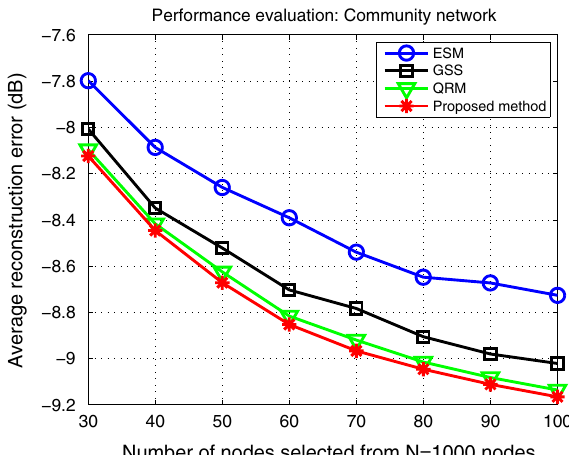
Fig. 5 Performance evaluation for noisy non‑bandlimited graph signals on CNG with σ = 0.1 by varying the sample size, | S